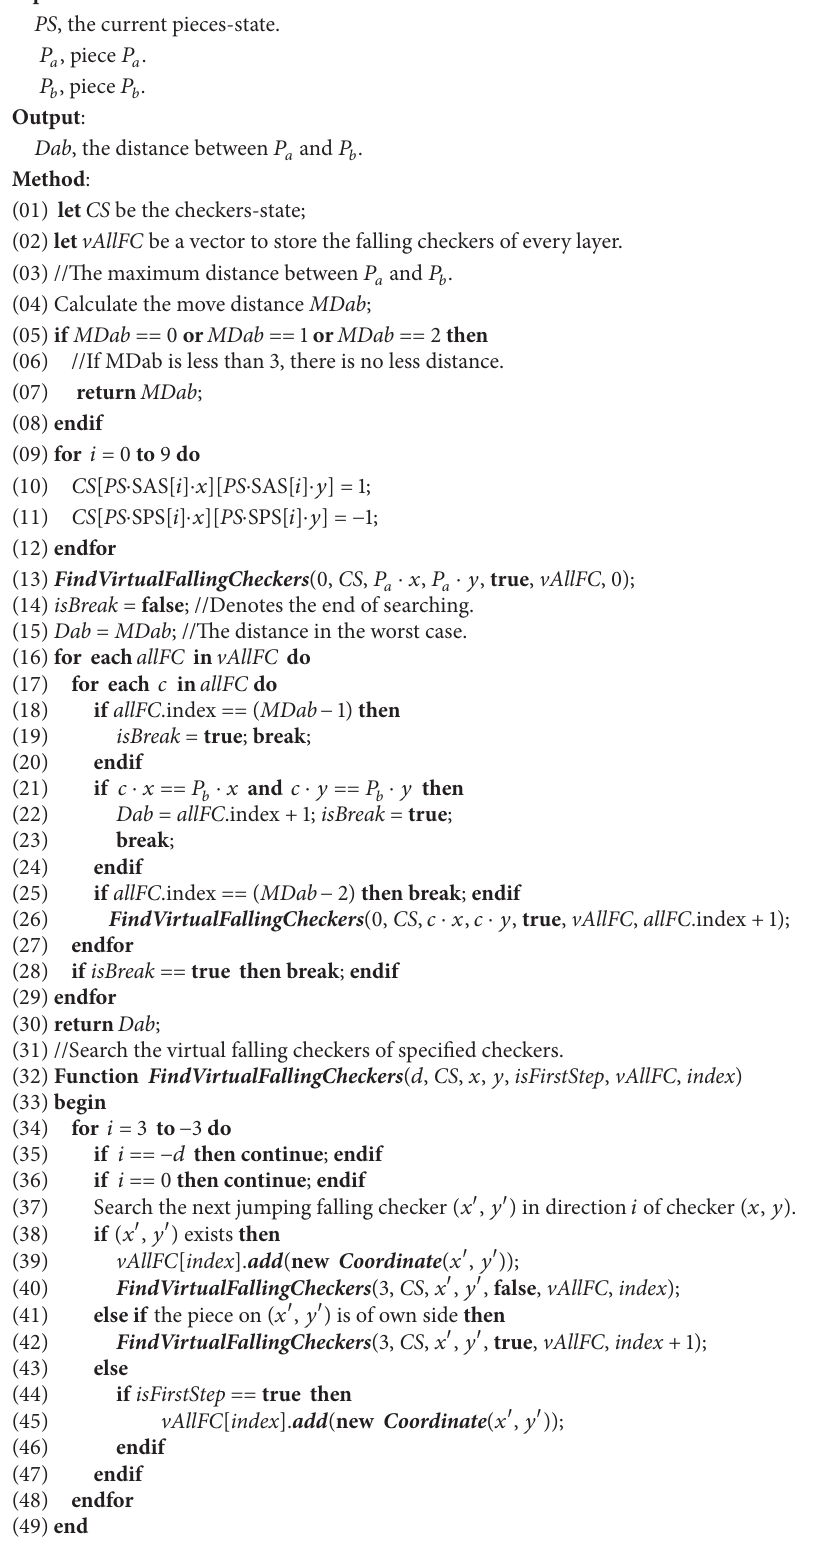
Procedure PiecesDistanceCalculation